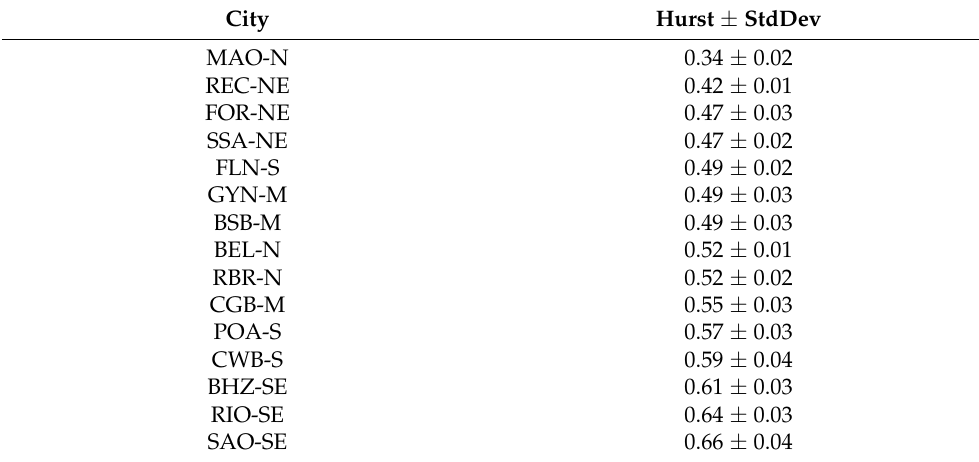
Table 5. DFA estimates for Brazilian